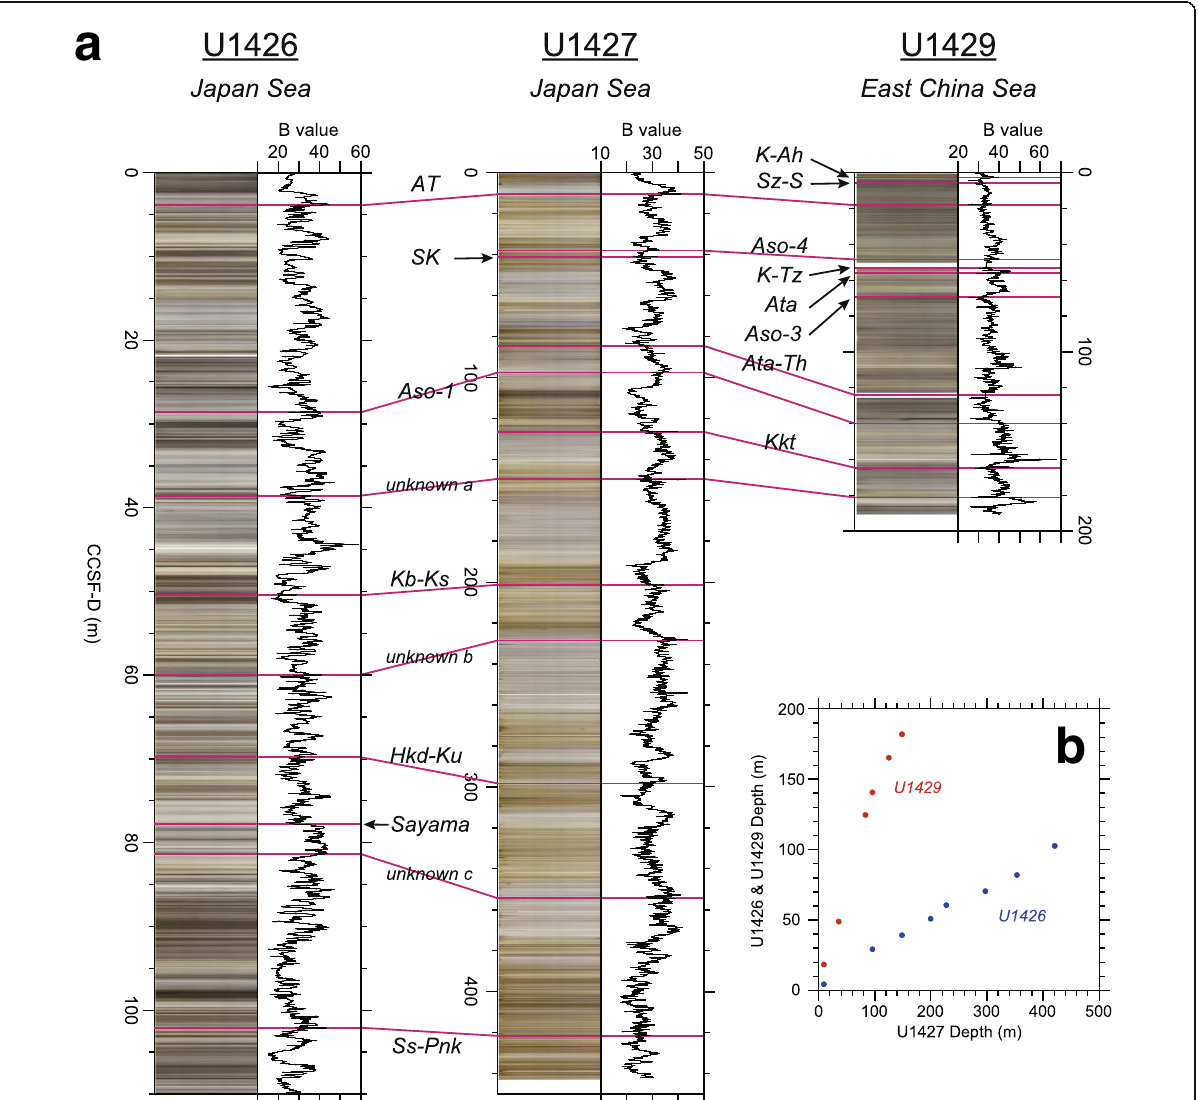
Fig. 2 a Composite images and color profiles of the studied intervals of Sites U1426, U1427, and U1429. Shipboard line-scan images of the surfaces of split sediment cores. Brightness and contrast of the images are enhanced to highlight color changes. Positions of regional tephras and correlative layers in the successions are indicated by magenta lines. b Depth relationships of correlative tephra layers between